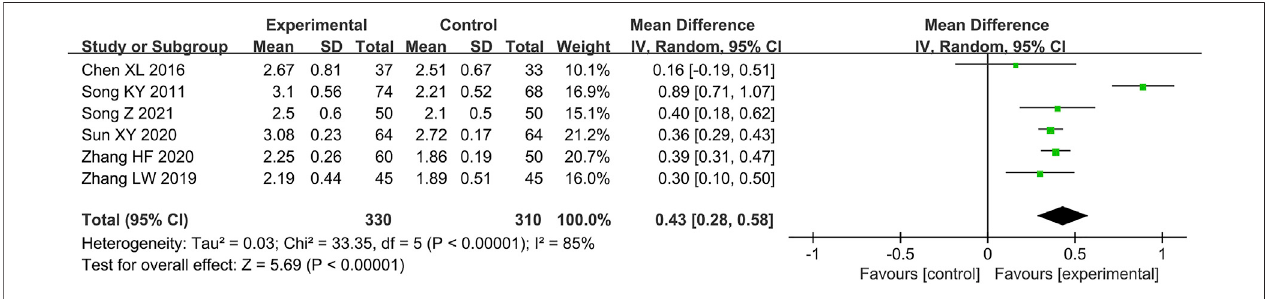
FIGURE 3 | Forest plot of